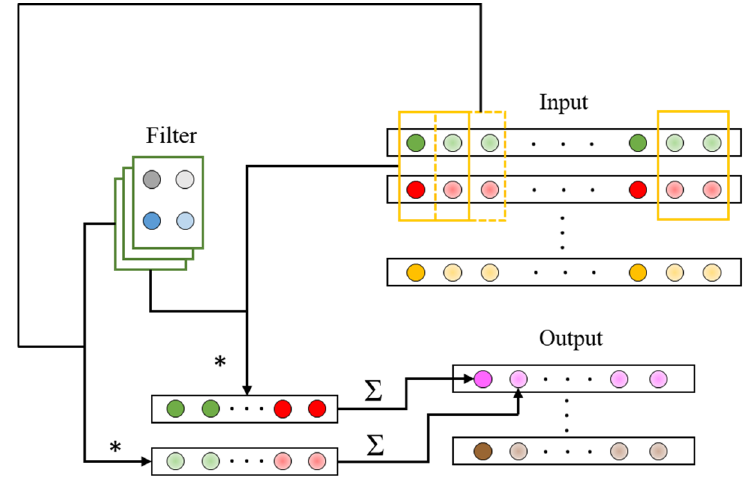
Figure 8. The essential components of CNN for dealing with time series, where * denotes the multiplication of elements at corresponding positions of the matrices.